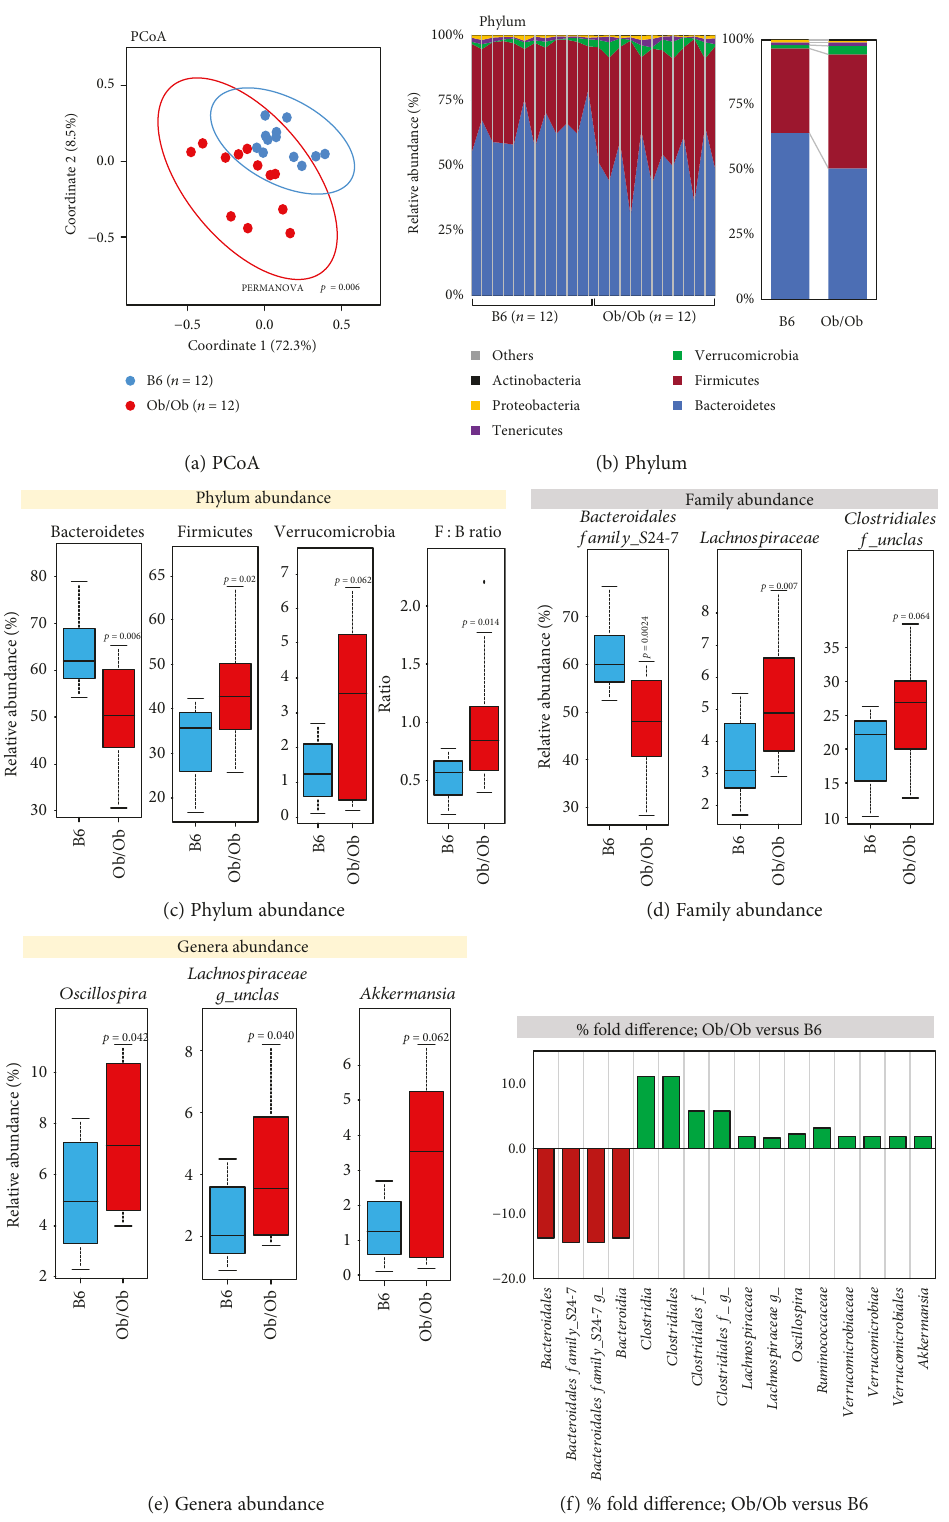
Figure 3: Lep ob/ob mice exhibit signi fi cant gut microbiome dysbiosis compared to C57BL/6J (B6) mice fed with identical diet. (a) PCoA analysis shows di ff erential clustering of the microbiome signature in Lep ob/ob and B6 mice. (b, c) Microbial phylum abundance and Firmicutes :Bacteroidetes (F: B) ratio in Lep ob/ob and B6 mice. (d – f) Signi fi cantly di ff ering microbial families (d) and genera (e) abundances as well as fold change (percent) between Lep ob/ob and B6 mice. Values presented here are average ±